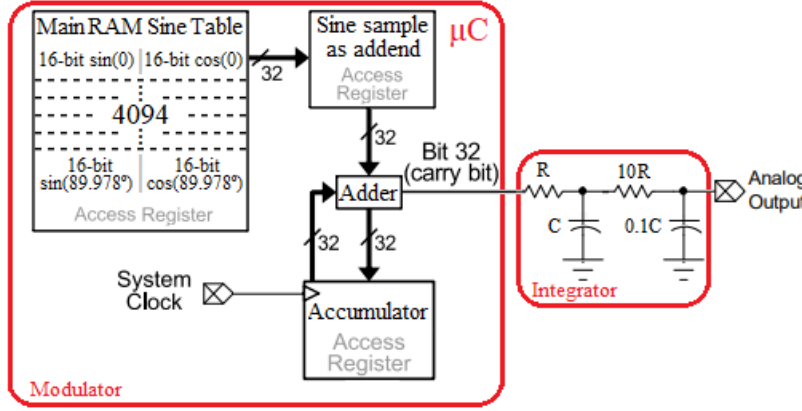
Figure 3. Signal generator hardware implementation based on D modulation.